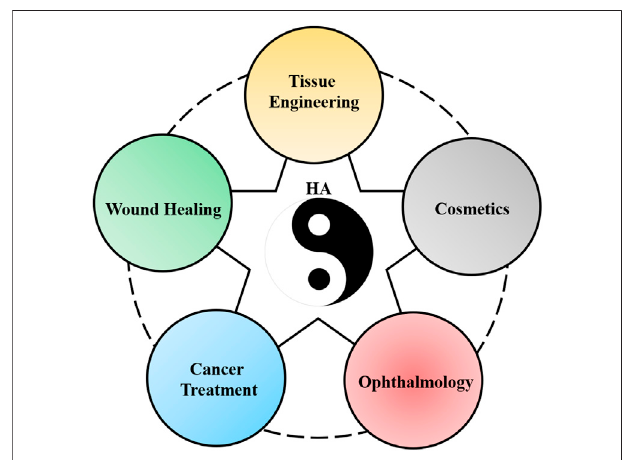
FIGURE 1 | Traditional Chinese- fi ve-element diagram is used to compare the application of HA in the following fi ve biomedical aspects: the “ Taiji ” in the middle indicates HA; the “ gold element ” indicates the tissue engineering application of HA; the “ wood element ” indicates the wound healing application of HA; the “ water element ” indicates cancer treatment applicationofHA;the “ fi reelement ” indicatestheophthalmologyapplicationof HA; and the “ earth element ” indicates the cosmetics application of